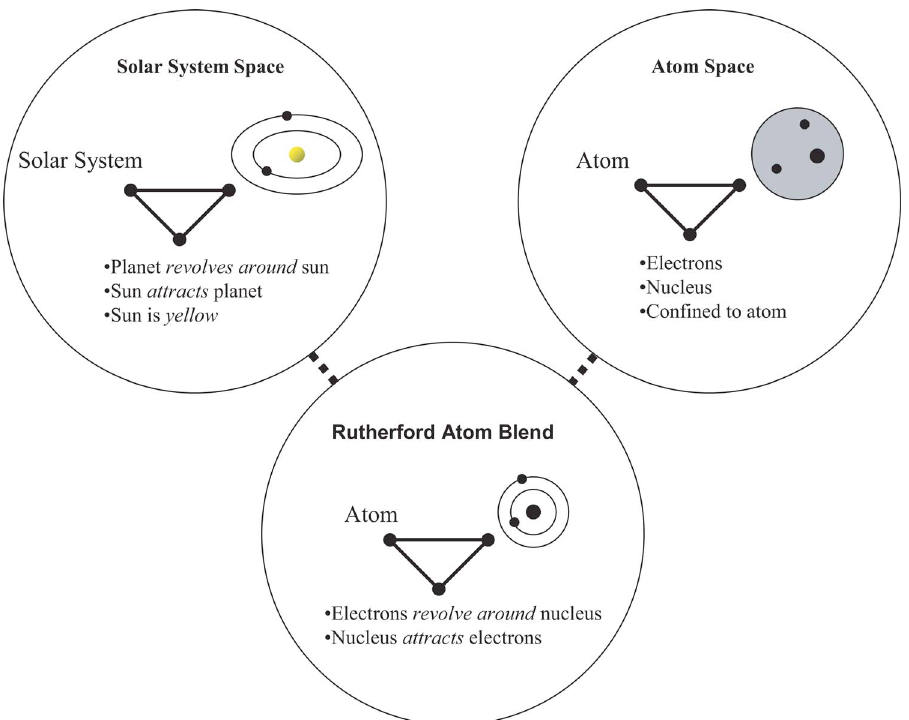
FIG. 4. (cid:1) Color (cid:2) Blending the solar system and a rudimentary model of